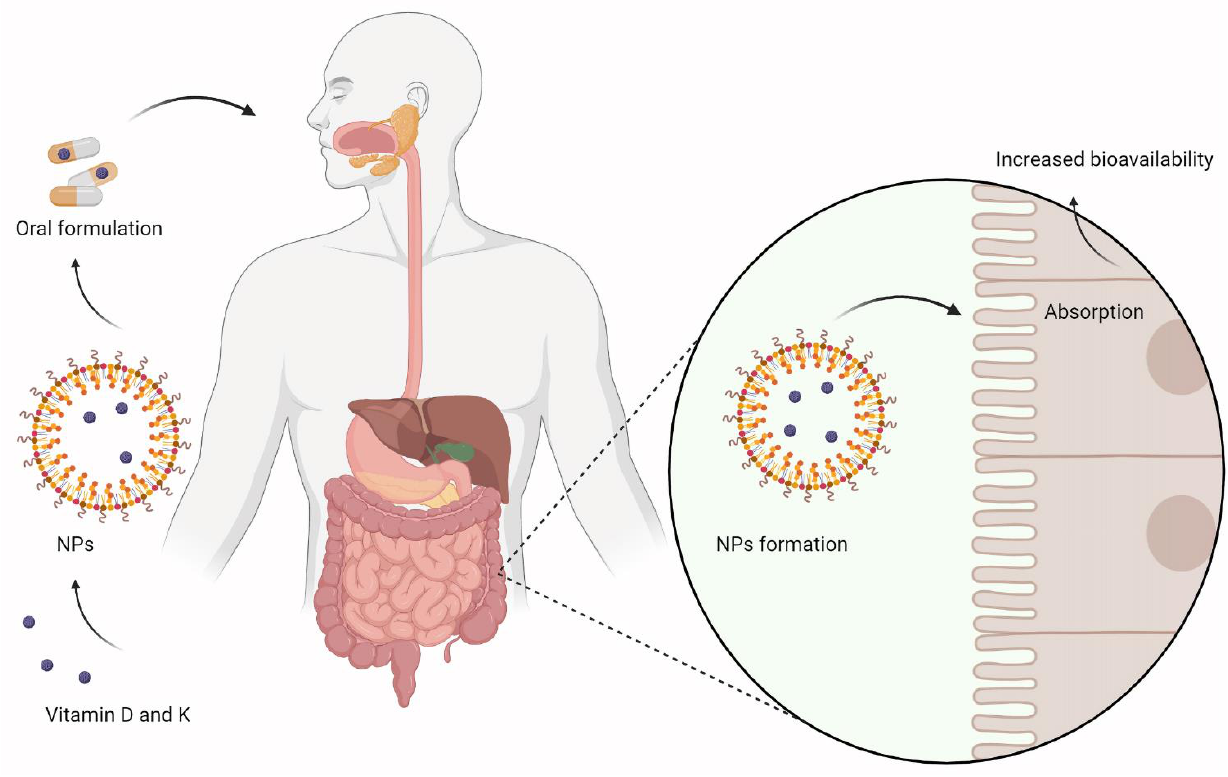
Figure 3. Use of nanocarriers to improve oral delivery of vitamins D and K.